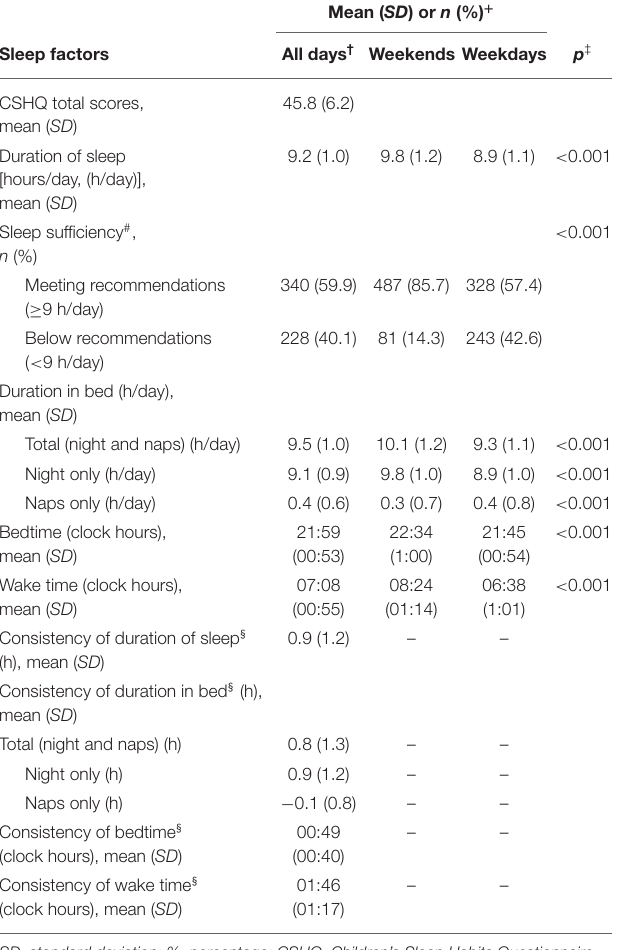
TABLE 1 | Summary of sleep patterns and Children’s Sleep Habits Questionnaire (CSHQ) scores in children from the Growing Up in Singapore Towards healthy Outcomes (GUSTO) cohort ( n =